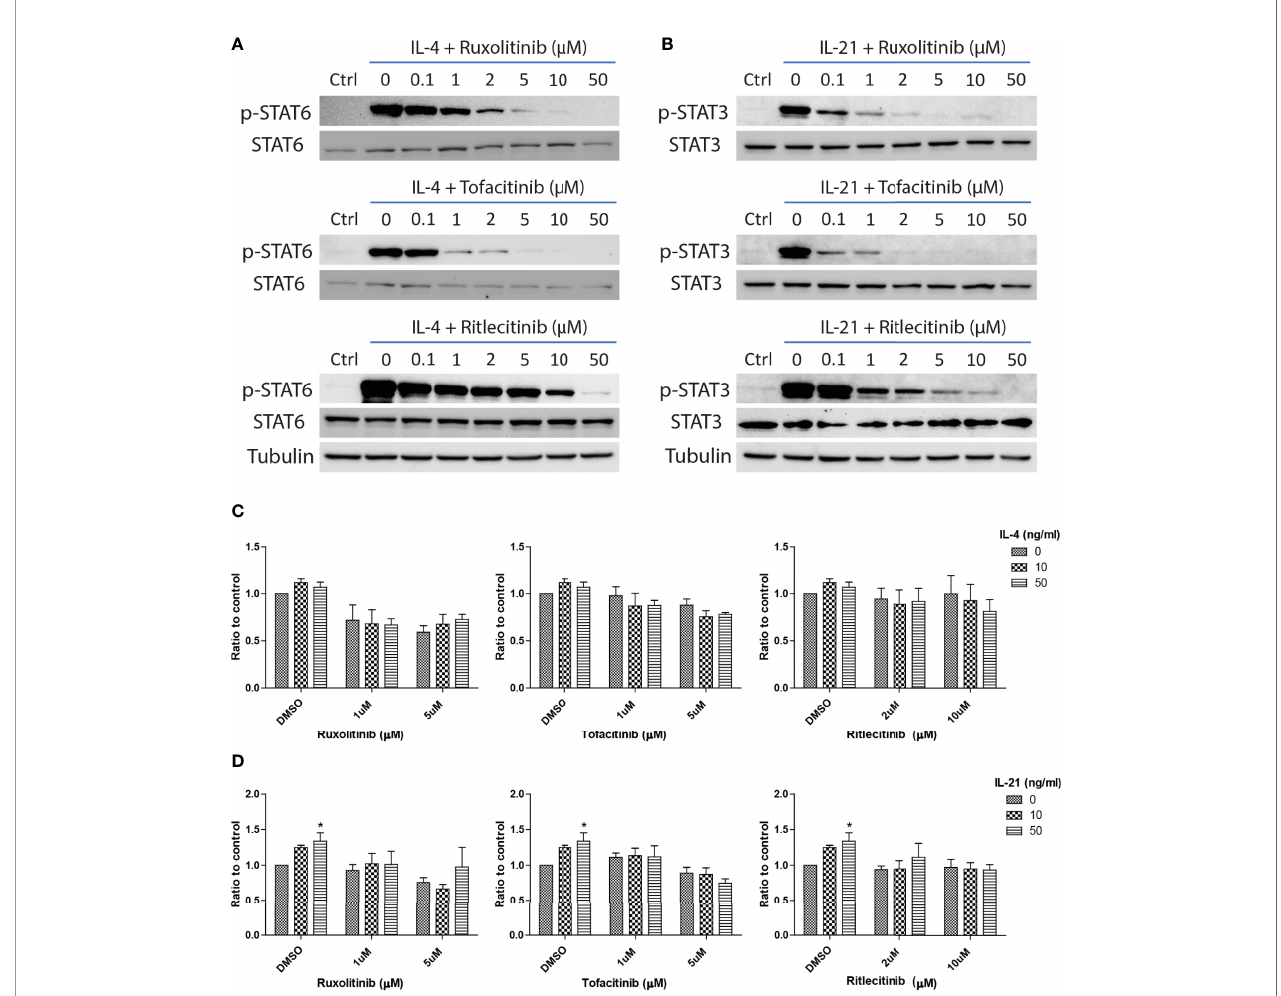
FIGURE 5 | JAK inhibitors suppressed IL-21 driven proliferative activities under anti-IgM challenge. Western blot analyses demonstrated that Ruxolitinib, Tofacitinib and Ritlecitinib inhibited (A) IL-4 triggered STAT6 phosphorylation and (B) IL-21 triggered STAT3 phosphorylation in a dose dependent manner. (C, D) WST-8 proliferative assays showed that all tested JAK inhibitors suppressed IL-4 and IL-21 rescues of anti-IgM arrested proliferation in Ramos cells. All groups shown in the fi gures were treated with 1 µg/ml anti-IgM for 48 hours. *p < 0.05 as compared to indicated DMSO control group by two-way ANOVA, N =